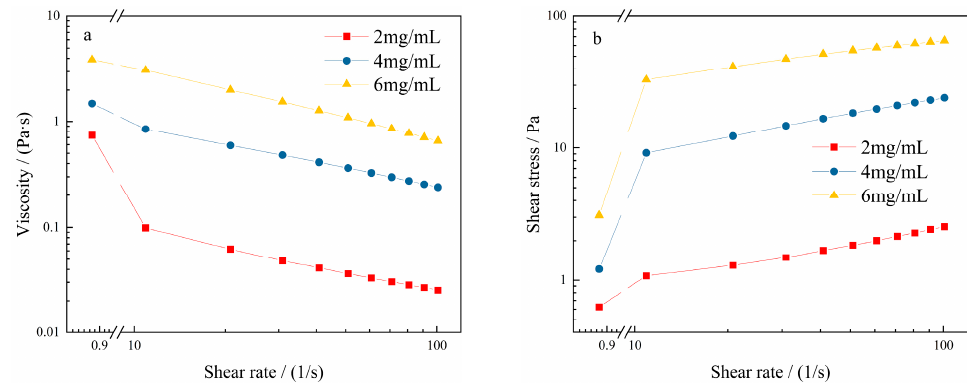
Figure 2. Rheological curves of KGM with different concentrations: ( a ) relationship between shear rate and viscosity; ( b ) relationship between shear rate and shear rate and viscosity; ( b ) relationship between shear rate and shear stress.